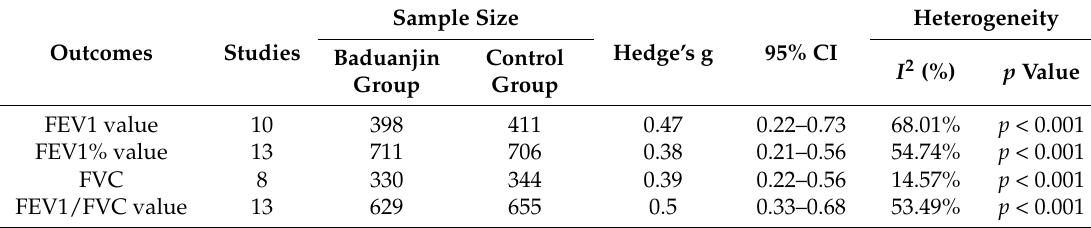
Table 3. Study results of meta-analysis regarding lung function parameters.